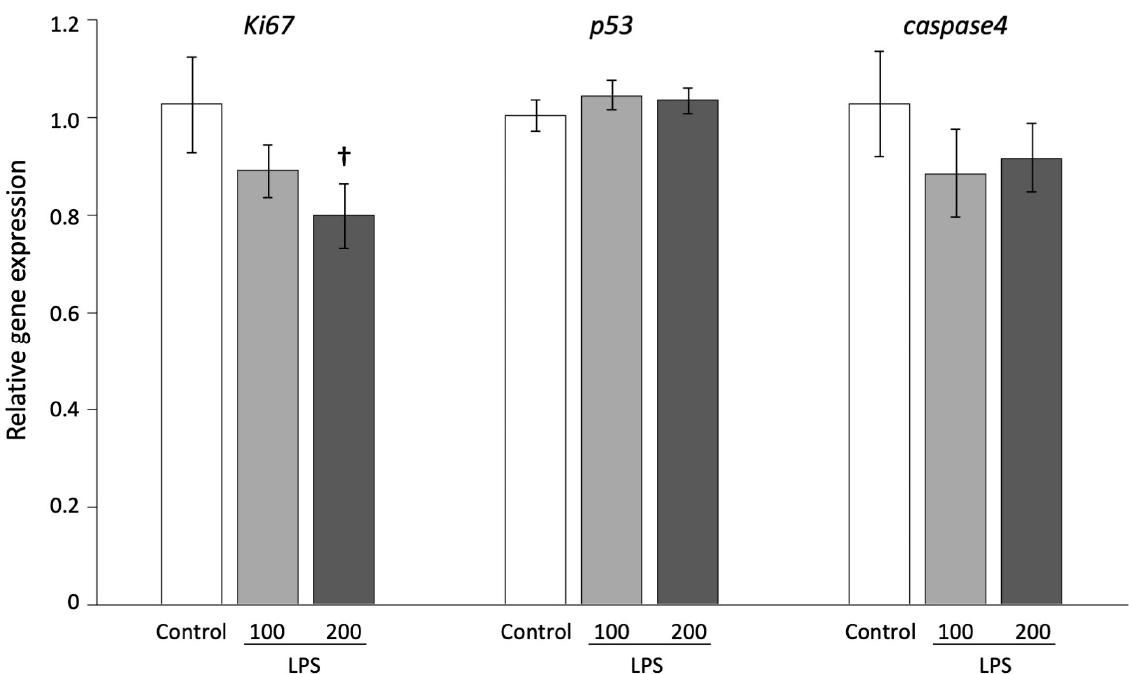
Figure 4. Gene expression of cell cycle and apoptosis markers in fetal tissue. The fetal tissues were collected at 18.5 dpc (n = 3) from litters of pregnant mice that had been administered 0, 100, and 200 µ g/kg LPS. The values are shown as the mean ± SEM. † p < 0.1. Table 3. Proportion and variables of the three principal components